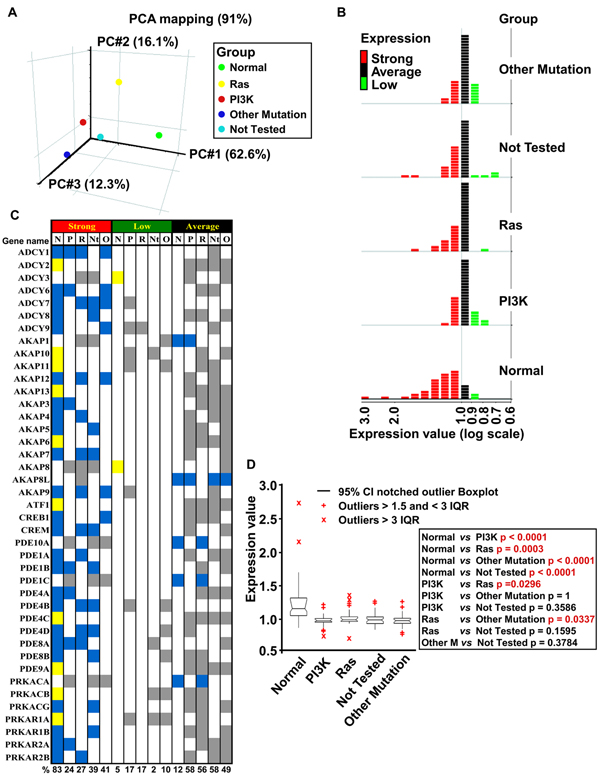
Identification of differentially regulated genes in normal and transformed samples. (A) Samples were sorted in five groups according to mutational activation: green, normal; yellow, Ras; red, PI3K; blue, Other Mutation; cyan, Not Tested. Principal Component Analysis (PCA) performed on 41 PKA pathway-encoding genes for normal samples and the four classes of mutation-dependent samples. Each sphere represents the comparative averaging of the 41 genes for each pathway identified by mutational analysis. (B) For each of the 5 groups described in (A), the 41 PKA-encoding genes were clustered, relative to their level of expression, in three subgroups: Strong (>1, red), Average (=1, black) and Low (<1, green). (C) Gene list according to expression level and mutational group of the three subgroups previously indicated, divided for each sample. Color-coding is as follows: blue, common between normal and at least one transformed sample; yellow, specific for normal samples; grey, specific for transformed samples. Percentage of regulated genes for each subgroup is shown at the bottom. (D) ANOVA analysis to evaluate the statistical significance of the differences between the five classes of samples described in (A). The right inset shows p-value of the pair-wise comparisons. Statistically significant differences are indicated in red. IQR: Interquartile Range. Outliers are also shown.